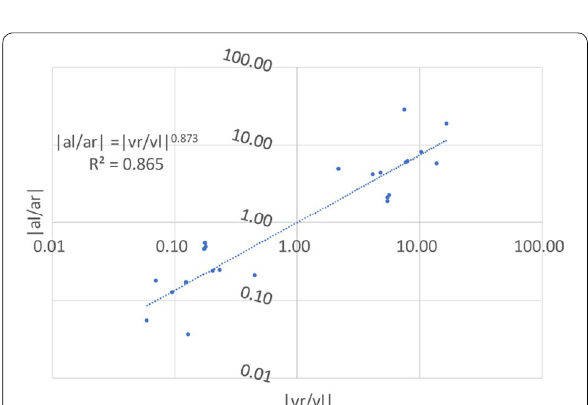
Fig. 13 Slip ratio and input velocity of each track in a double loga- rithmic